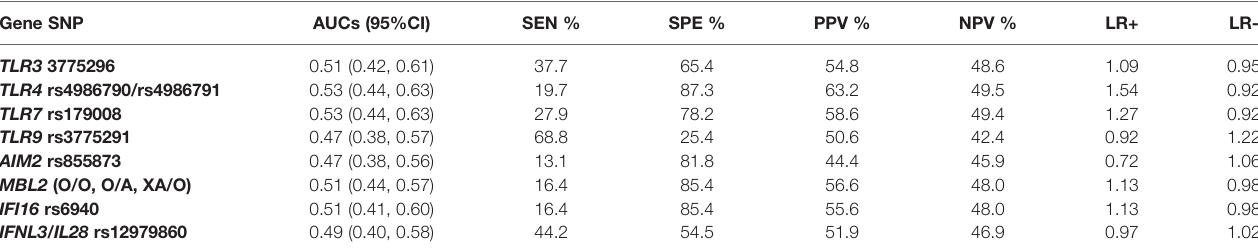
TABLE 4 | Area under the ROC curve (AUCs) of innate immune receptor gene SNPs for the prediction of CMV disease patients in SOT recipients with sensitivity and speci fi city. Gene